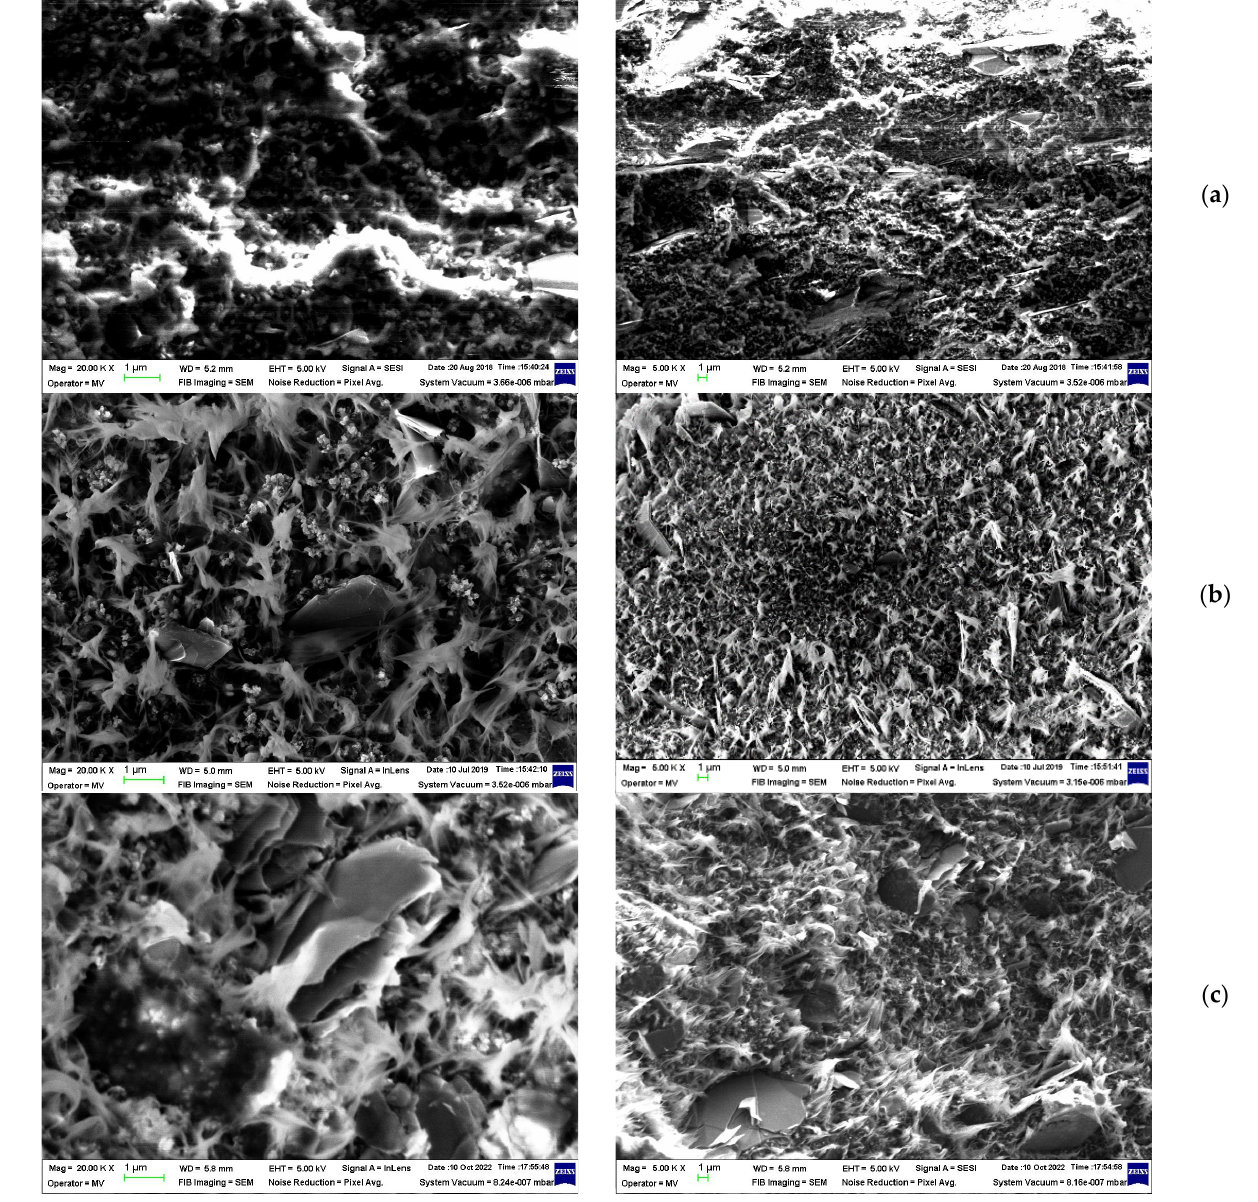
Figure 4. SEM images of (CB + Gr)/HD composite stored for different periods at r.t.: ( a ) freshly pre- pared sample; ( b ) stored for one year; ( c ) stored for four years. In the first column, the magnification is 20 kx while in the second one, it is 5 kx.